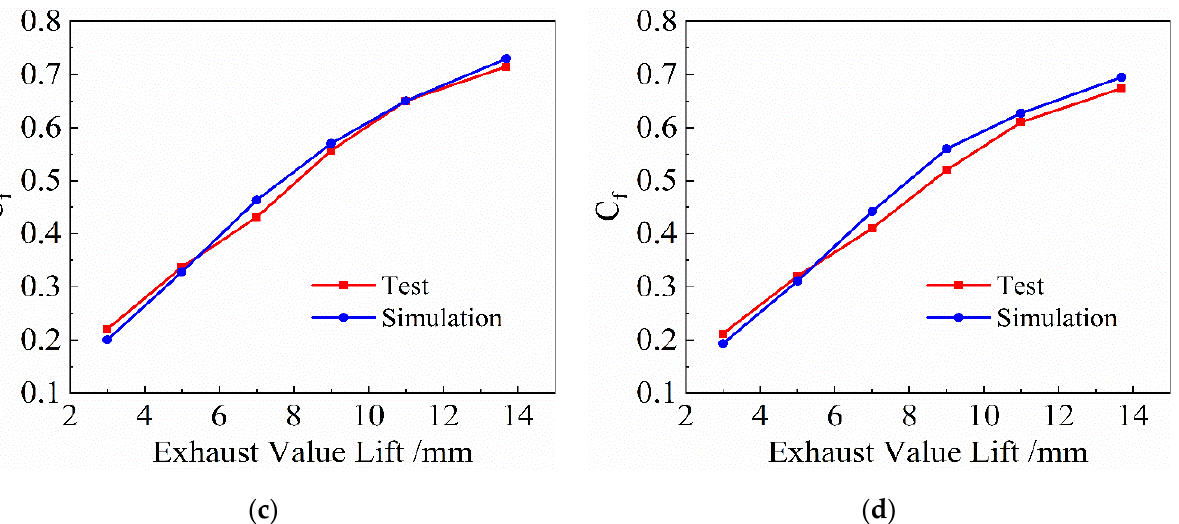
Figure 8. ( a ) Comparison of test and simulation results of 45 mm-throat intake port; ( b ) comparison of test and simulation results of 46 mm-throat intake port; ( c ) comparison of test and simulation results of 46 mm-throat exhaust port; ( d ) comparison of test and simulation results of 47 mm-throat exhaust port.